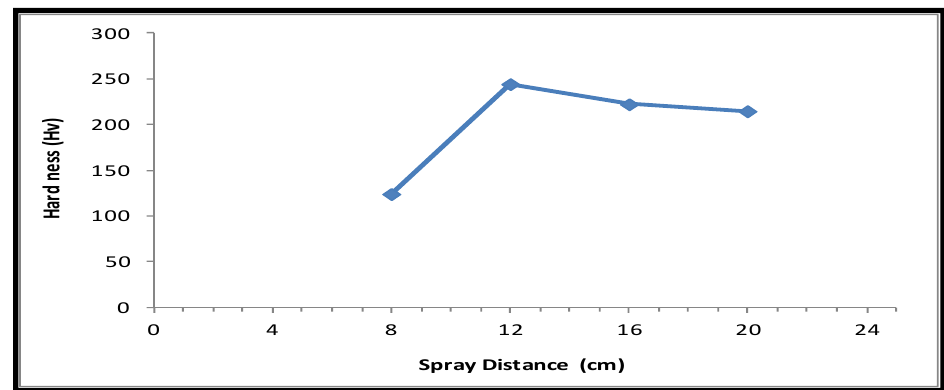
Fig.7: Hardness relation with spraying distance before thermal